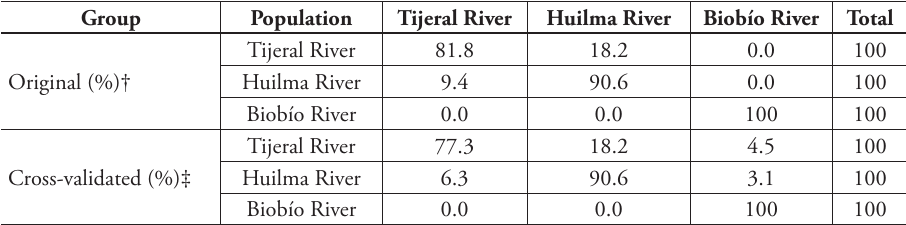
Table 4. Percentage of Trichomycterus areolatus specimens from populations of southern Chile correctly classified into their original group and after